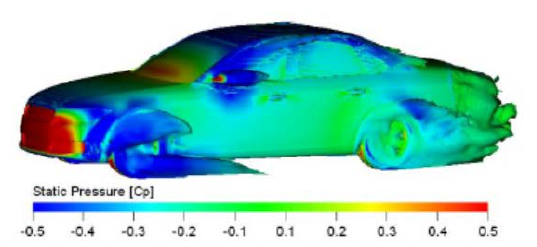
Figure 19. Isosurface map of vehicle surface when total pressure is zero.